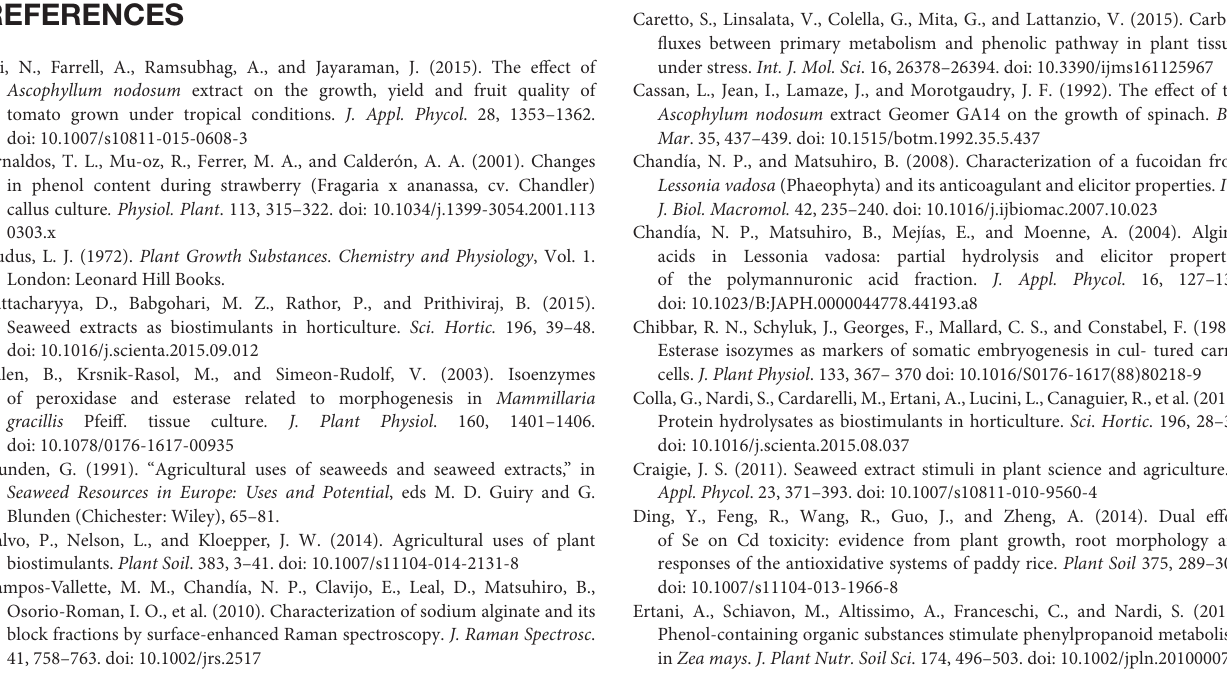
Figure S1 | Heat map of plant-associated parameters influenced by individual seaweed extracts. Different colors indicate different levels of induction ( + , ++ , + + + ), repression ( − ) or no effect ( =